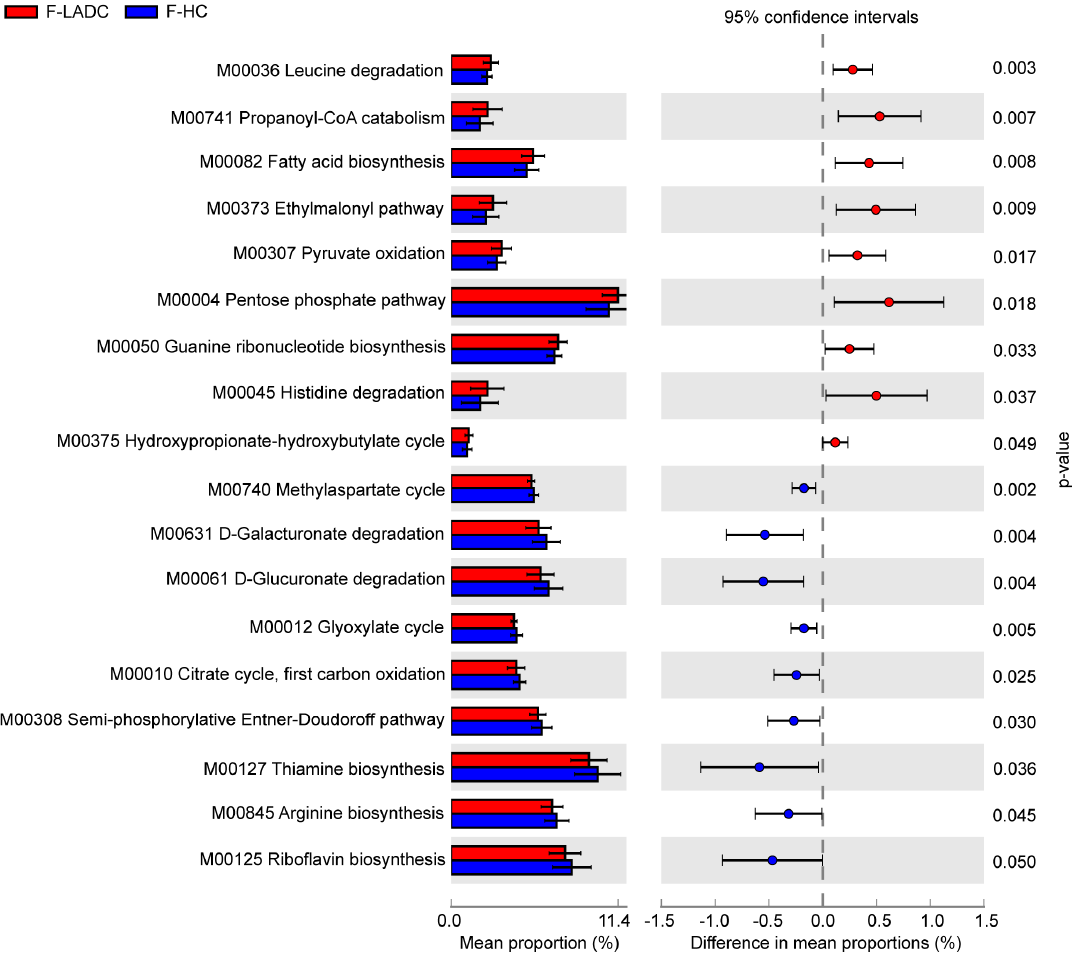
Figure 6. KEGG modules that differ significantly in relative abundance between the gut samples of patients with LADC and healthy controls. The statistical analysis was performed and visualized using the STAMP software. The mean proportion and the difference in the mean proportions for pathways showing a significant difference in abundance are shown. The 95% confidence intervals and statistical significance ( p < 0.05) are also indicated. Red and blue represent the patients with LADC (n = 43) and healthy controls (n = 64), respectively. A two-sided Welch’s t test was used to identify the significantly different metabolic pathways between the two groups, with p < 0.05 considered signifi- cant.